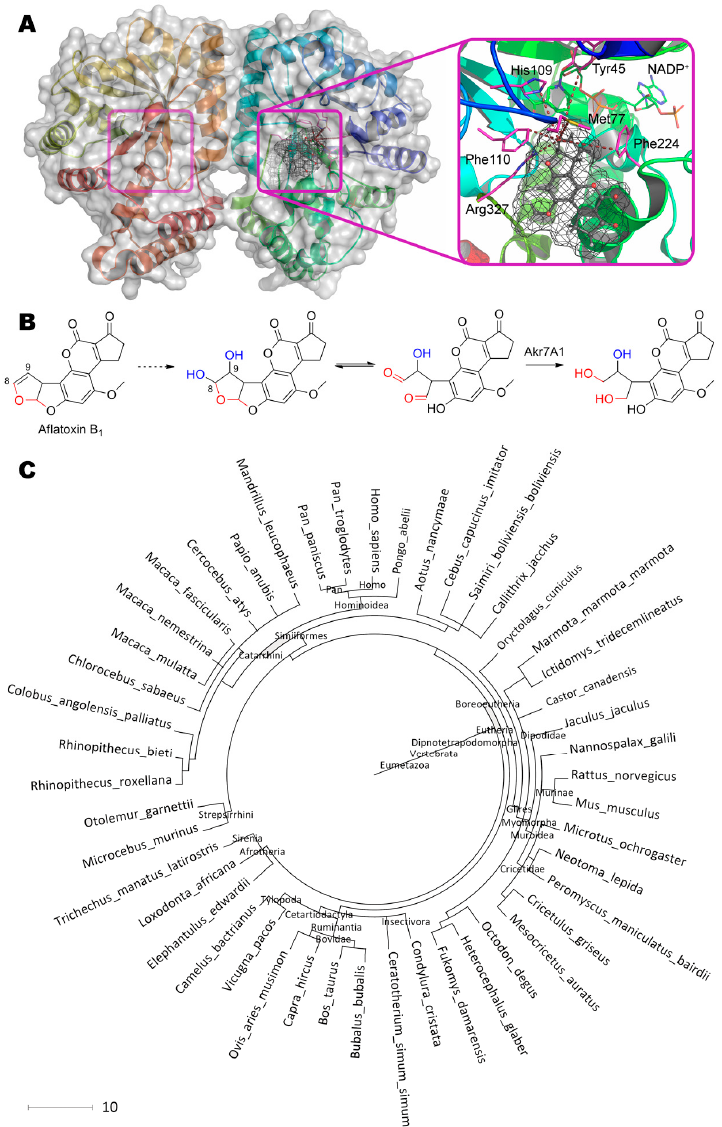
Figure 2. ( A ) Structure of aflatoxin dialdehyde reductase AKR7A1 (PDB 1gve) containing aflatoxin B 1 in its active center, and ( B ) scheme of substrate conversion with AKR7A1. Position and geometry of substrate binding was determined using molecular docking with Autodock Vina as described [15] (see Appendix A for details). Molecular surface of substrate was calculated using Gamess-US as described [16] and is shown as mesh. Within reaction scheme, OH-groups marked with blue are introduced by cytochromes, and oxygens marked with red are modified by AKR7A1. ( C ) Phylogenetic tree of organisms possessing homologous enzymes found with BLAST.